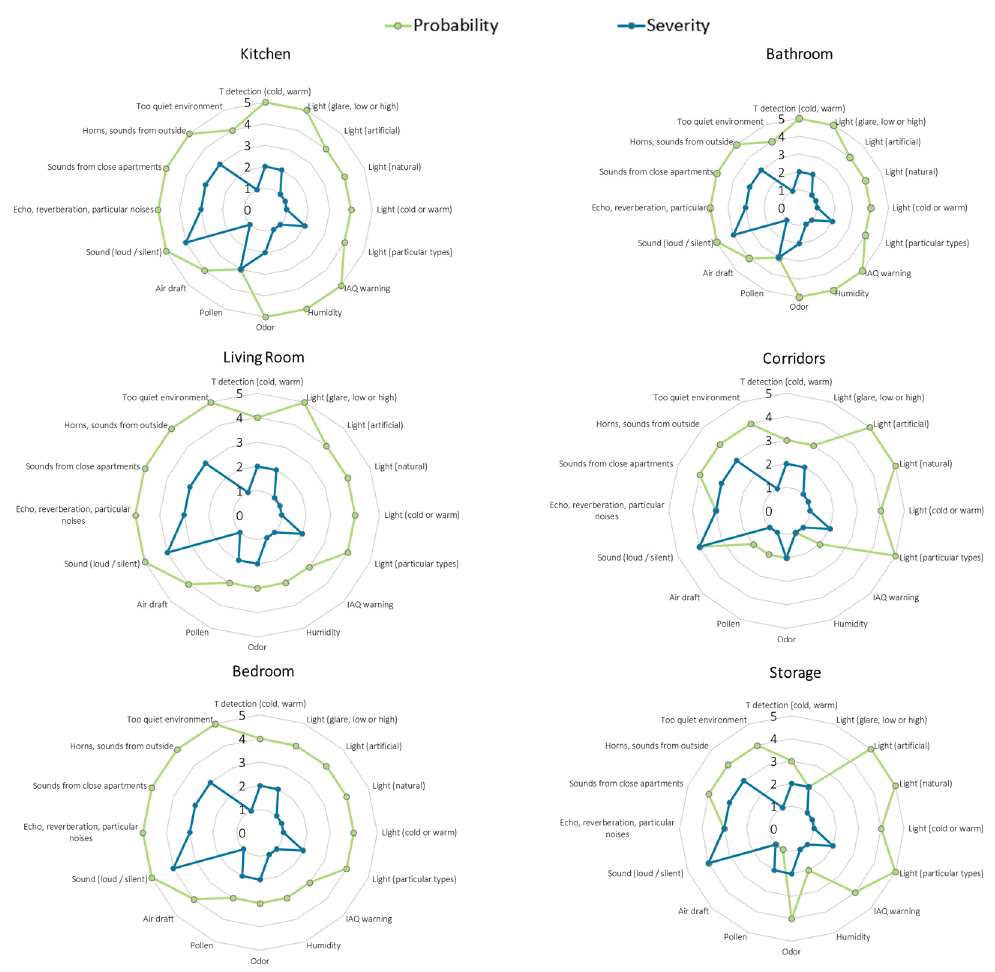
Figure A1. Environmental risks: probability and severity in the rooms of a typical living environ- ment.